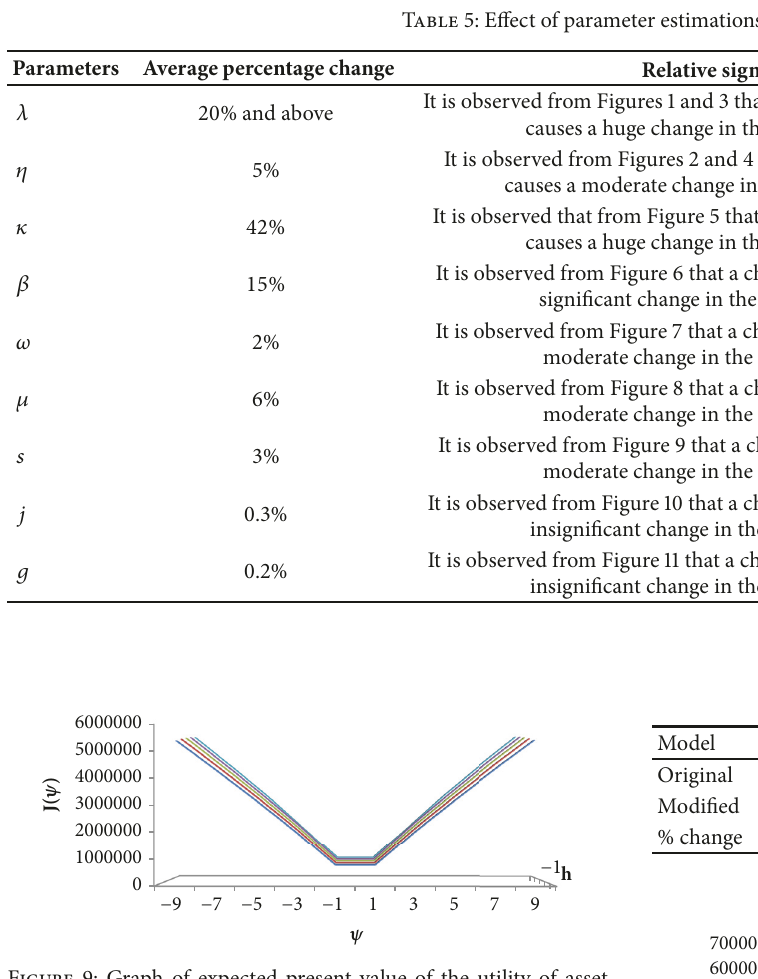
Figure 9: Graph of expected present value of the utility of asset 𝐽(𝜓) versus control 𝜓 and asset supply ratio 𝑠 while subjective discount rate 𝜂 and degree of relative risk 𝜆 are fixed at 0.1 and 0.9 , respectively.